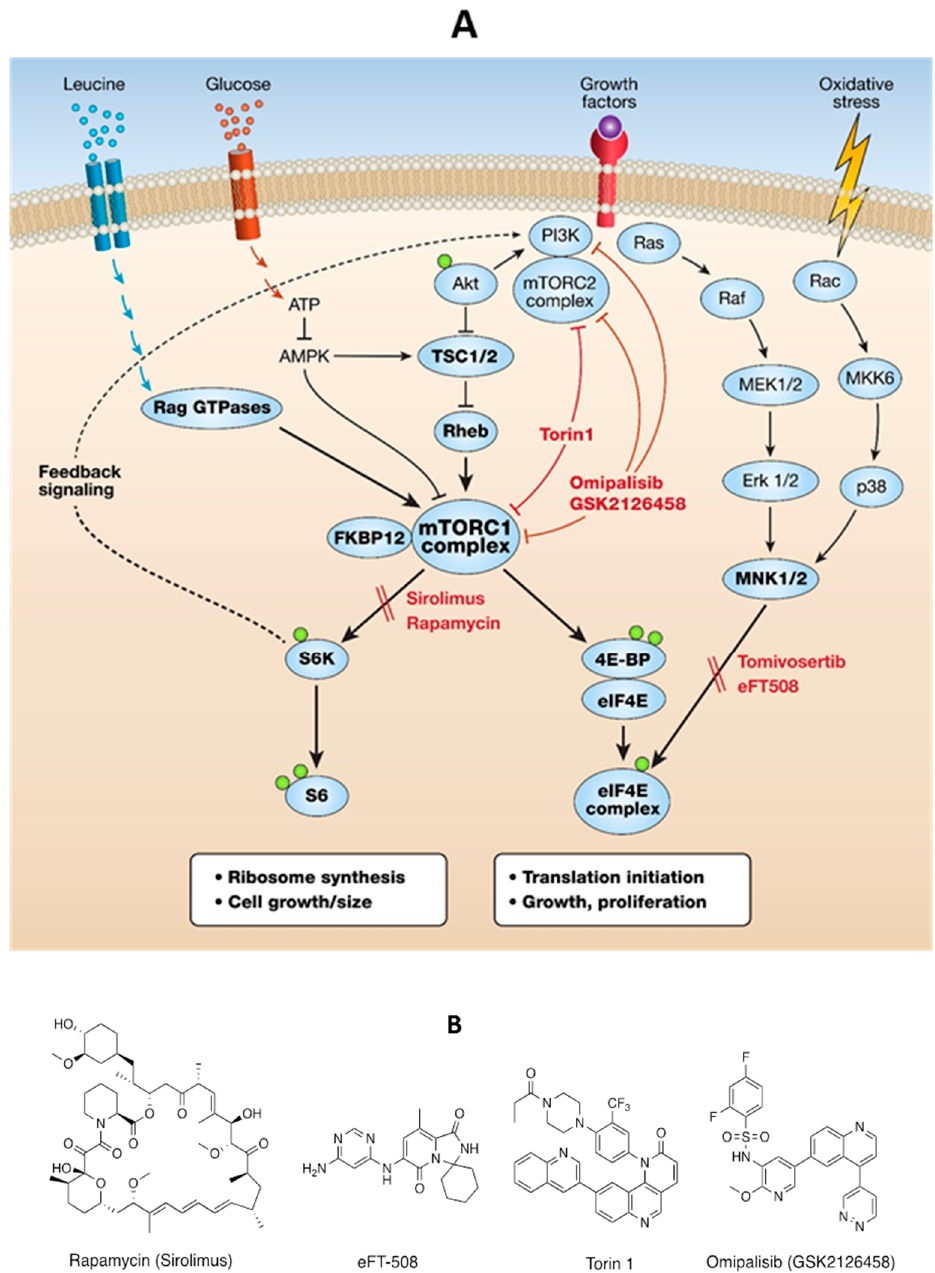
Figure 1. Schematic of mTORC1 growth pathways and inhibitors used in this study. ( A ) Cells respond to extracellular growth conditions by modulating mTOR activation. The mTORC1 complex is controlled by Rheb GTPase activation, which is regulated by TSC1/2 suppressor proteins. Oxidative stress or other external signals might activate MNK1/2 kinases, resulting in the phosphorylation of eIF4E. eIF4E is a critical protein in the eIF4F initiation complex for translation of cancer-related proteins. Green circles represent phosphorylation sites relevant to this study. Tomivosertib (eFT508) is a selective inhibitor of MNK1/2. Sirolimus (rapamycin) allosterically inhibits mTORC1, preferentially inhibiting the S6K/S6 pathway. Torin1 catalytically inhibits mTORC1 and reduces both the S6K/S6 and 4E-BP/eIF4E protein synthetic branches. Omipalisib (GSK2126458), a dual PI3K/mTOR inhibitor, inhibits the phosphorylation of Akt, mTOR, S6K/S6, and 4E-BP/eIF4E. ( B ). Chemical structures of compounds.